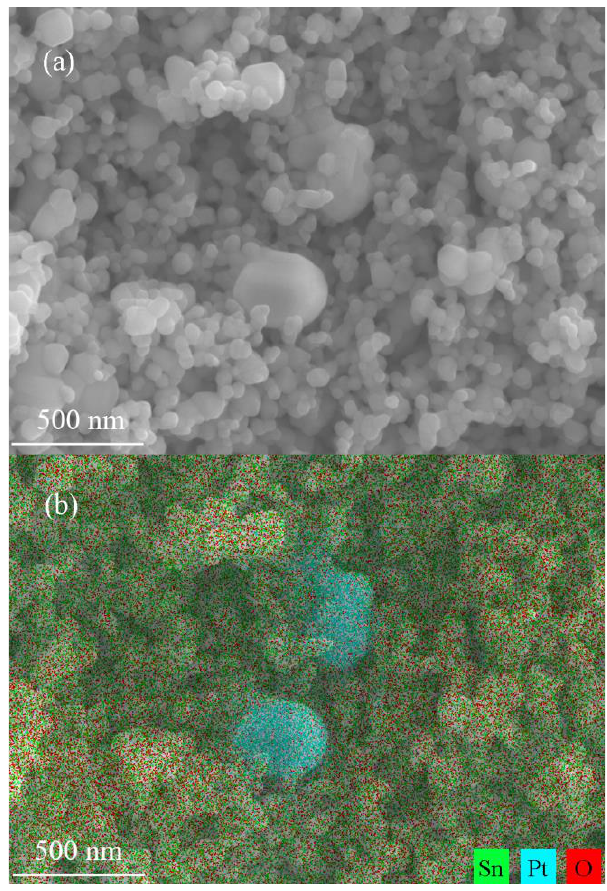
Figure 3. ( a ) SEM micrograph taken on a fractured surface and ( b ) SEM micrograph with EDS analysis for a pellet of 5 wt% Pt sintered at 825 °C for 2 h in air.